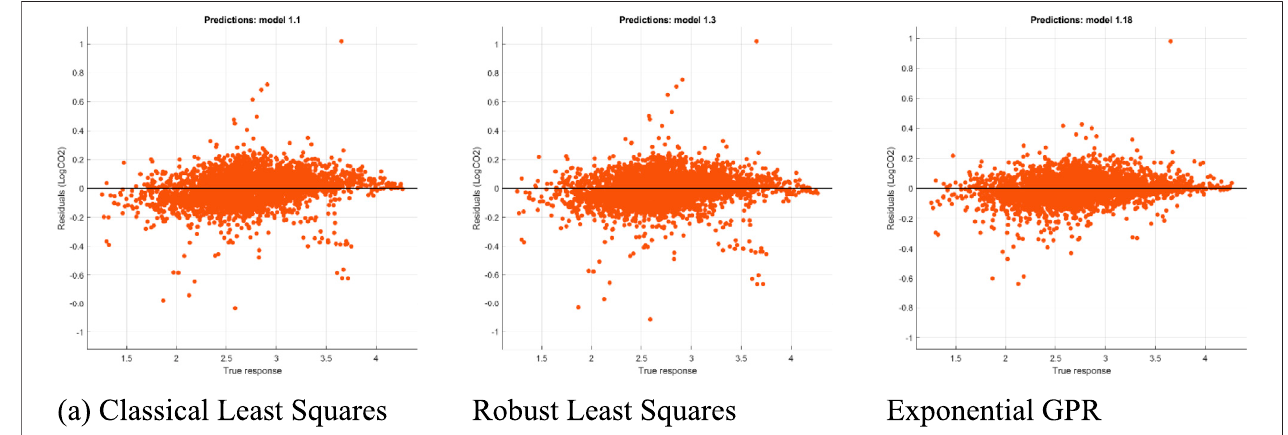
FIGURE 2 | The deviation of actual value and prediction of CO 2 emissions between the selected models. (A) Classical Least Squares, Robust Least Squares, Exponential GPR. Notes: 1) The horizontal axis represents actual CO 2 emissions in logarithm, and the deviation of the actual extremity of the CO 2 emission from the predicted value is represented by the vertical axis. 2) CO 2 emissions are measured in ten thousand tons of